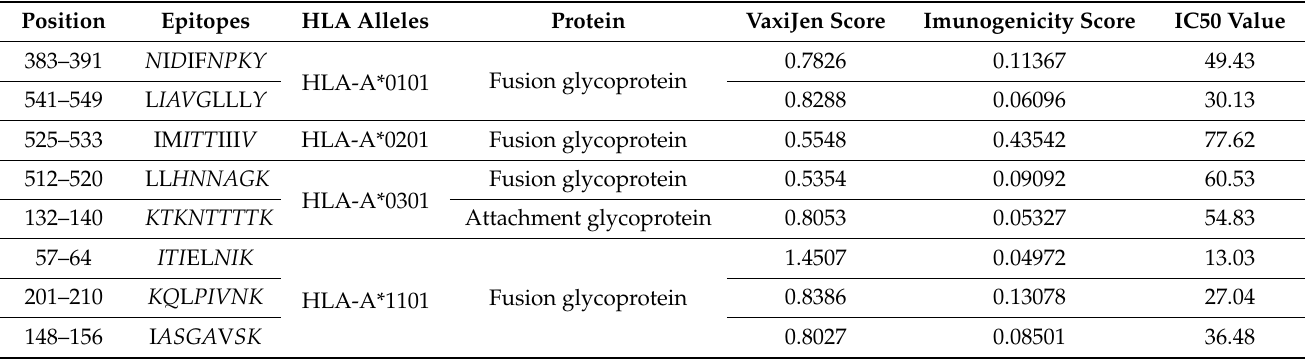
Table 1. The overall attributes associated with the selected eight HLA I interacting T-cell epitopes. In epitope sequence, exposed residues are bold and italicized, while the rest are buried residues as predicted by the WESA tool.